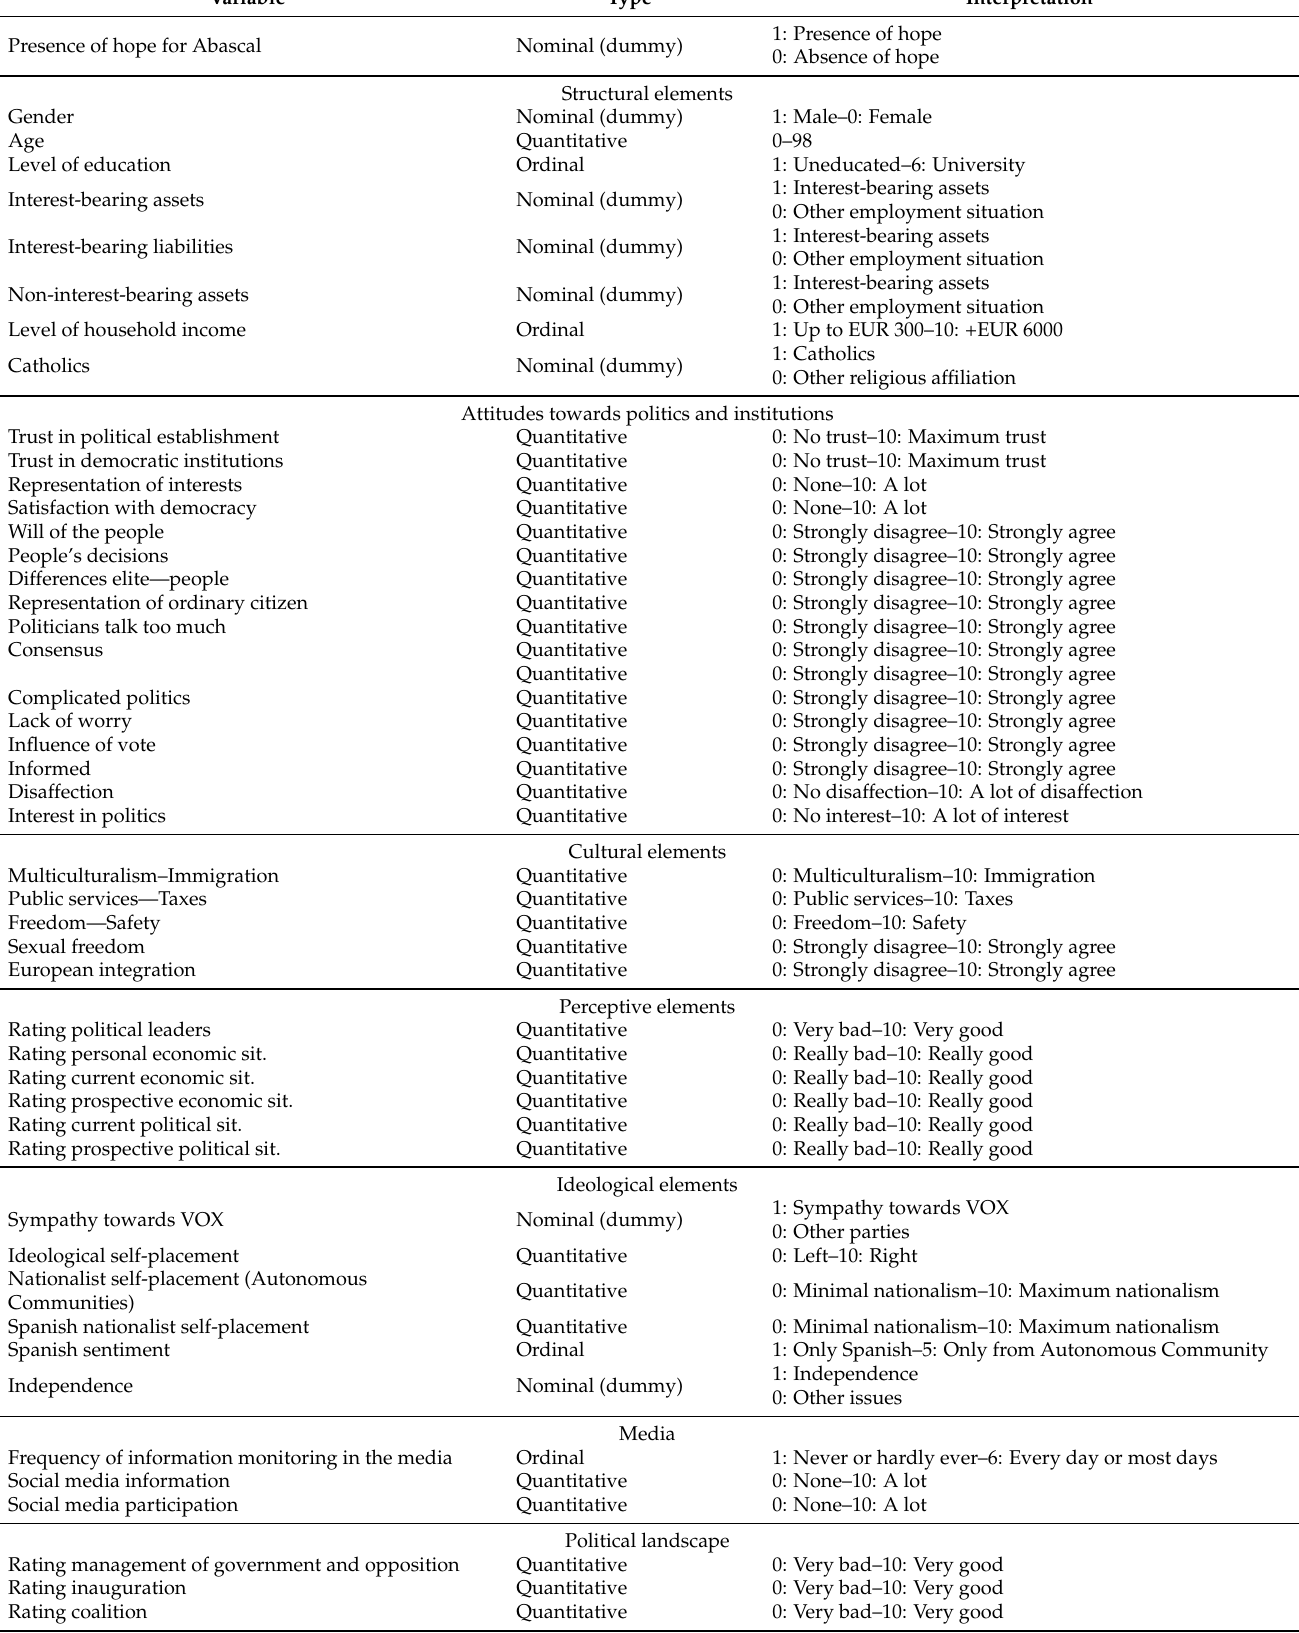
Table A2. Variables introduced in the explanatory models of the hope towards Abascal. Variable Type